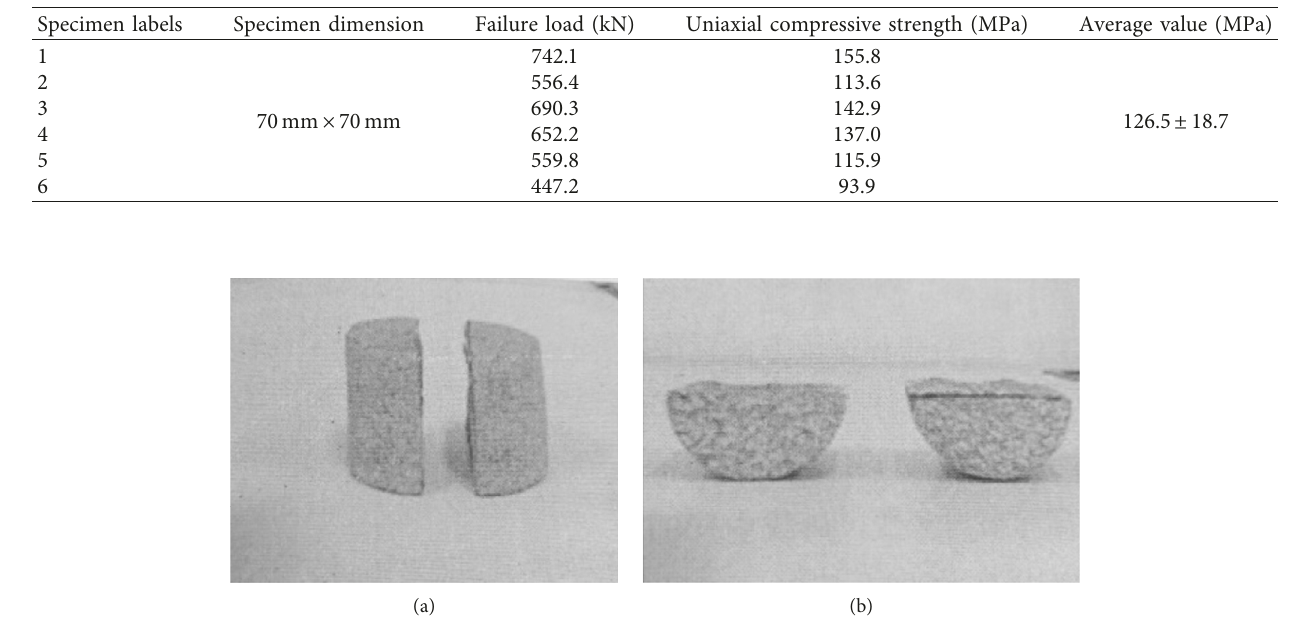
Figure 3: Failure mode of tensile splitting test for granite. Table 2: Tensile splitting strength results for